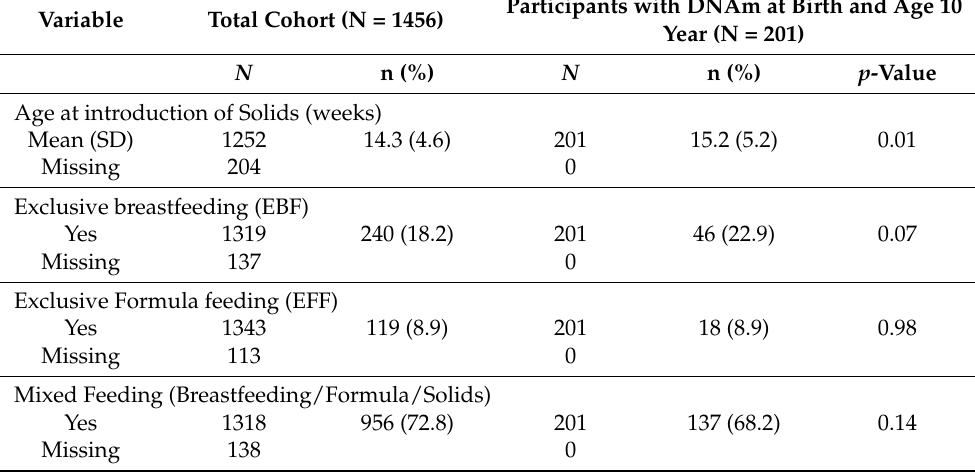
3.2. EWAS of Infant Feeding Duration and Changes in DNA Methylation The training-testing method ( ttScreening ) analyzing 292,366 delta-residuals detected 87 informative CpGs across all the three feeding variables (27 CpGs for EBF, 48 CpGs for EFF, and 12 CpGs for mixed feeding) (Figure 2). The delta-residuals of these CpGs were further analyzed using linear regression models by controlling for confounders. After adjusting for multiple testing (FDR = 0.05), all CpGs remained significantly associated with three infant feeding variables (Table 2).